Question: Write the caption for this figure.
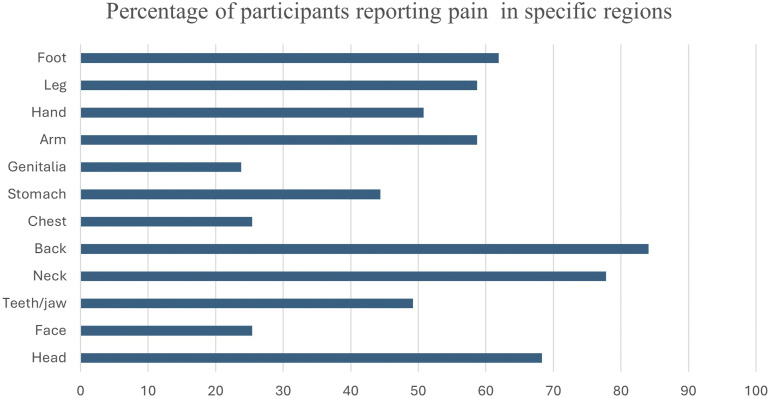
Answer: Percentage of participants reporting pain in specific regions. Note. Percentages include participants reporting widespread pain.